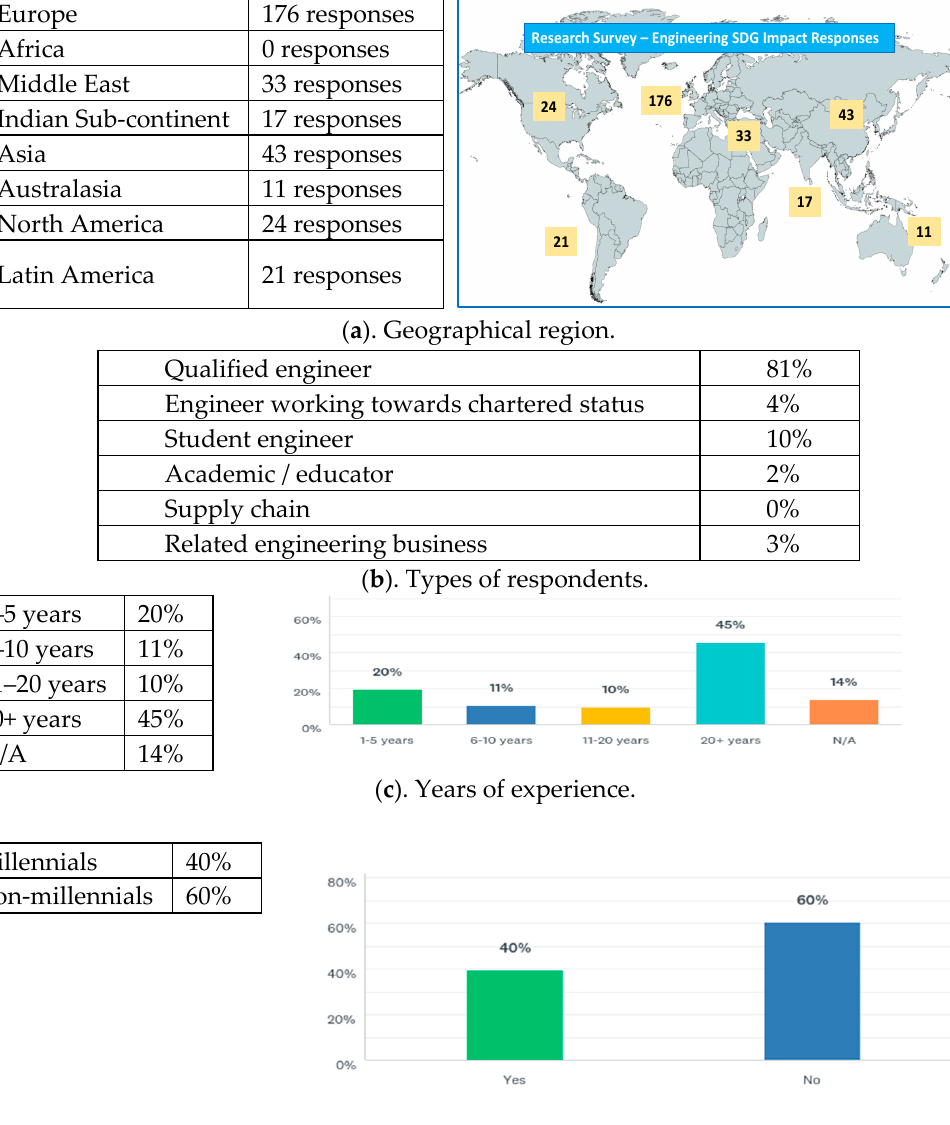
Figure 7. Response to Question 1: Should engineering businesses seek ways to measure and report SDG impact? Relation to the research question: the data suggest that engineers rate the use of SDG for measuring impact is important, and this provides a starting point for delving deeper into the context, mechanism and outcomes issues that affect its application. Differences analysis: there were few differences, and this strengthened the findings.